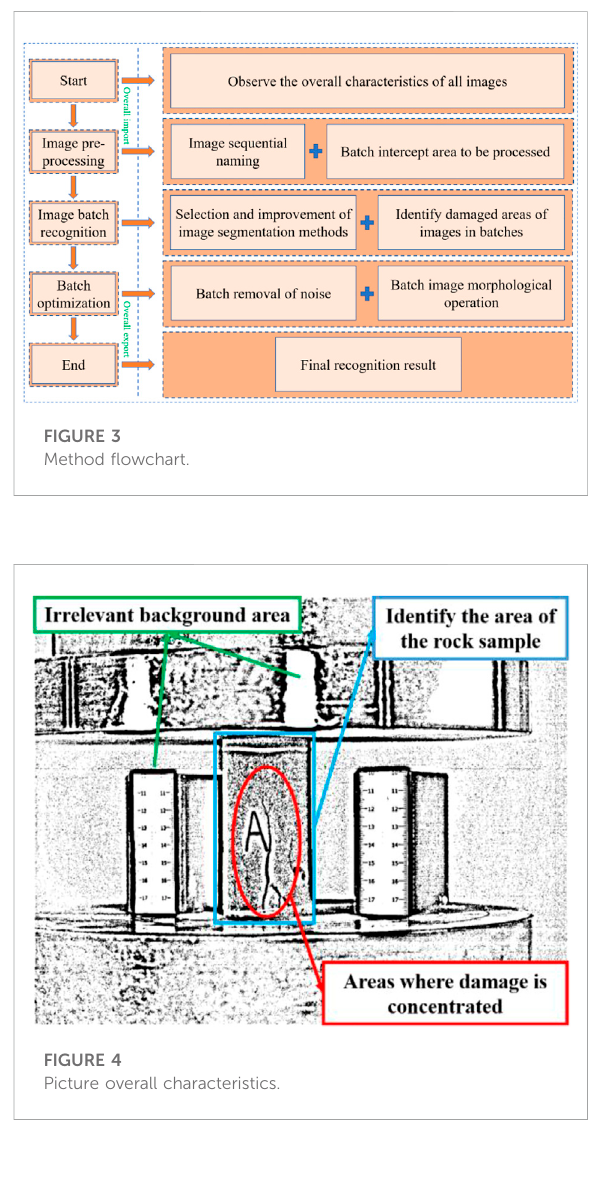
FIGURE 4 Picture overall characteristics.